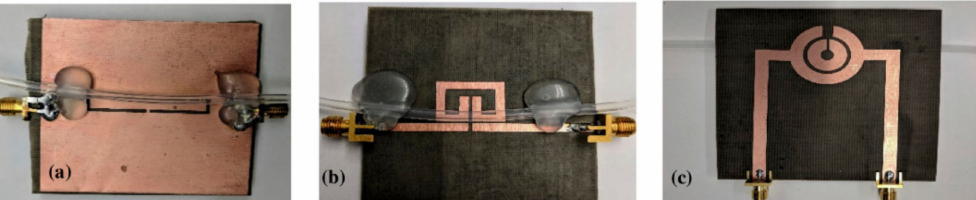
Figure 10. The geometries of the proposed three sensors, based on the complementary sprit ring resonator (CSRR) ( a ), extended gap SRR (EX-SRR) ( b ), and circular SRR ( c ) [98]. Reprinted from Sharafadinzadeh, N.; Abdolrazzaghi, M.; Daneshmand, M. Investigation on planar microwave sensors with enhanced sensitivity from microfluidic integration. Sensors Actuators, A Phys. 2020 , 301 , 111752, doi:10.1016/j.sna.2019.111752 with permission from